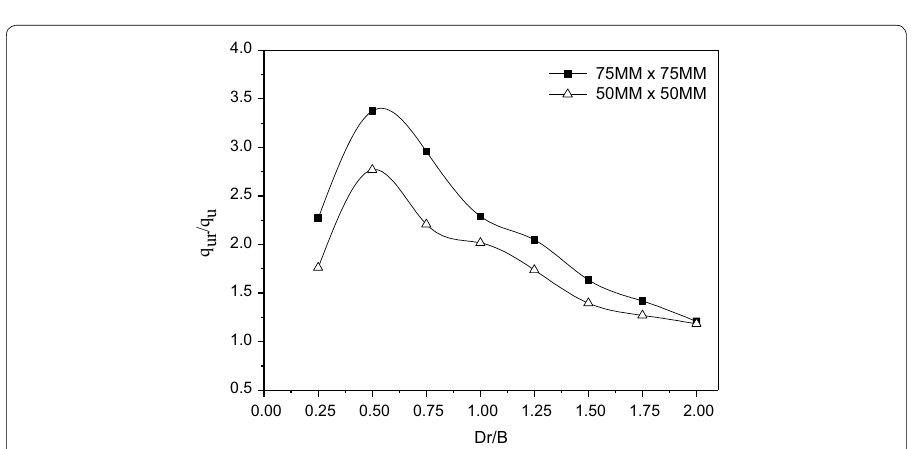
Fig. 5 Bearing capacity ratio vs Dr/B using geojute as reinforcement